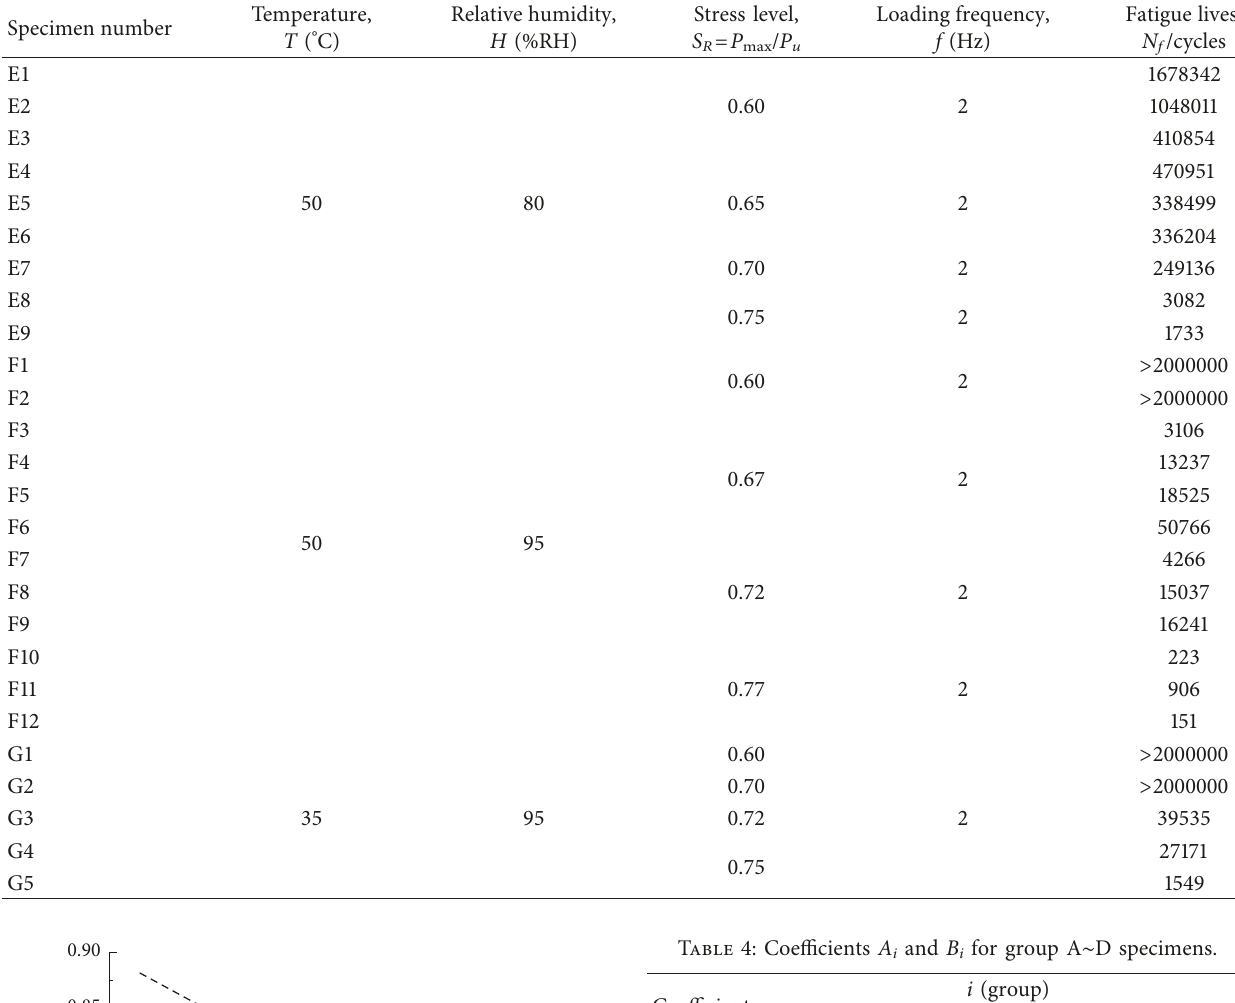
i and B i for group A